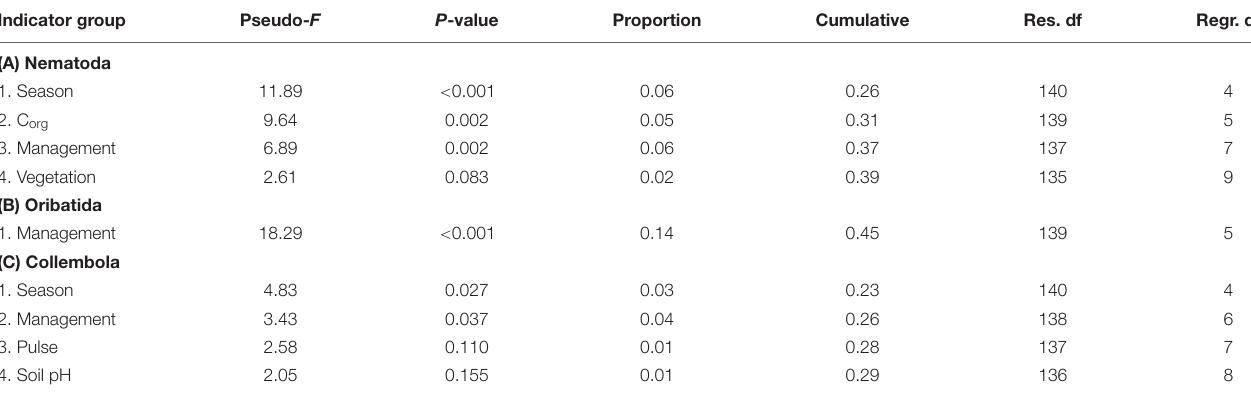
TABLE 4 | Results of distance-based linear models (DistLMs) testing for effects of indicator groups ( Table 2 ) as predictors for (A) Nematoda genus, (B) Oribatida species, and (C) Collembola species richness. Indicator group Pseudo- F P -value Proportion Cumulative Res. df Regr.